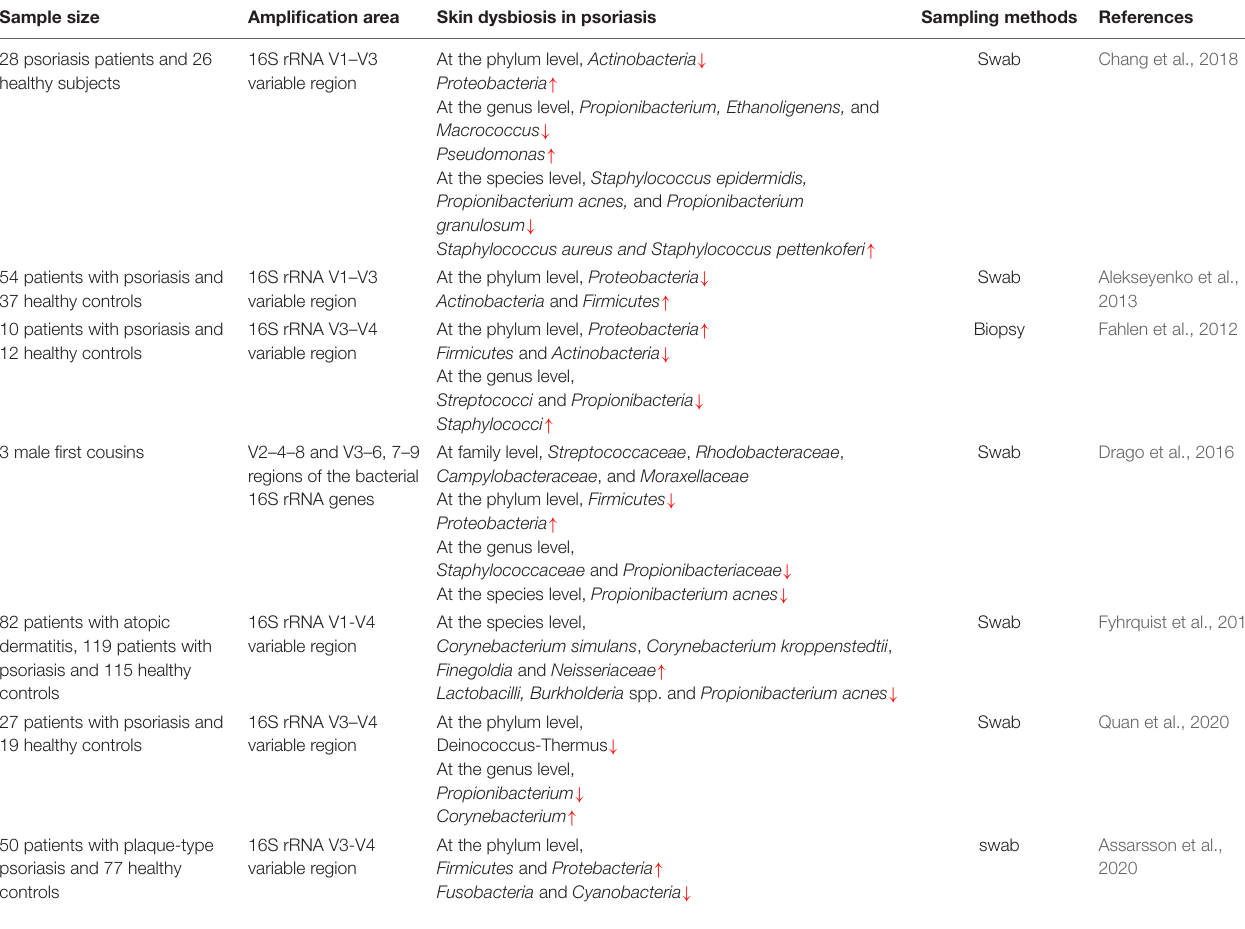
TABLE 1 | Reported skin dysbiosis in